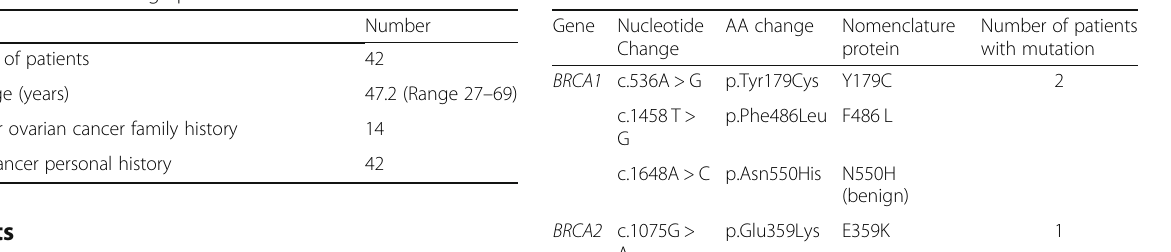
Table 3 BRCA VUS detected in the